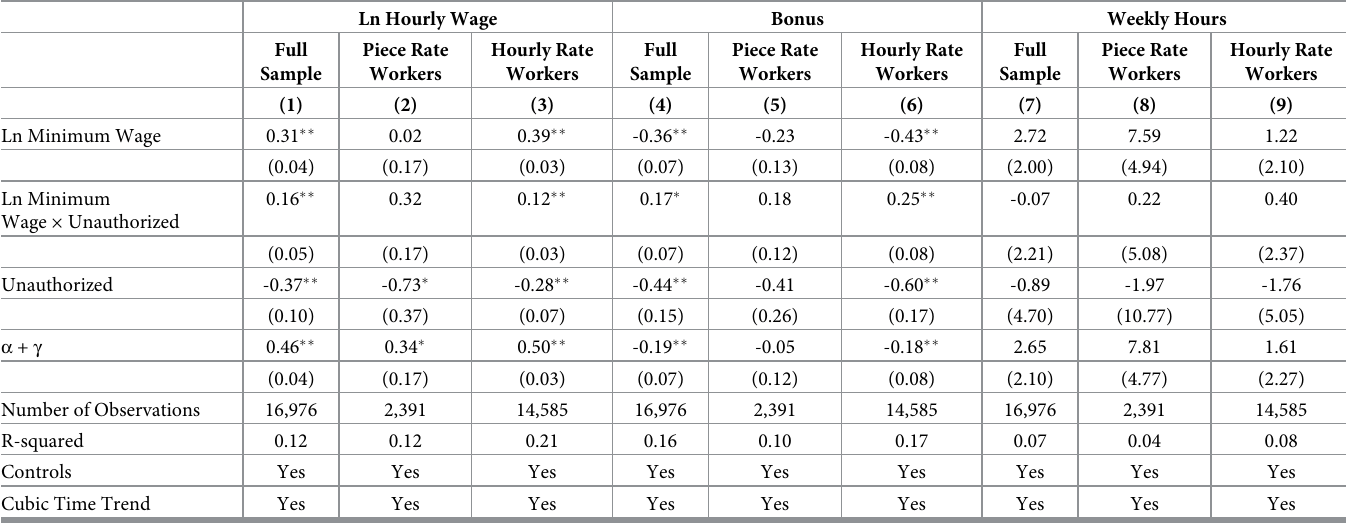
Table 5. Minimum wage law and hourly wage, bonus, and weekly hours